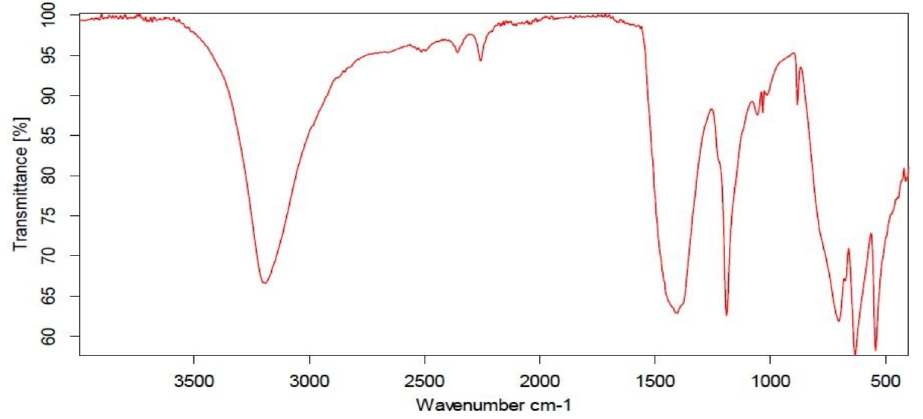
Figure 2. IR of MoO 3 -NPs.